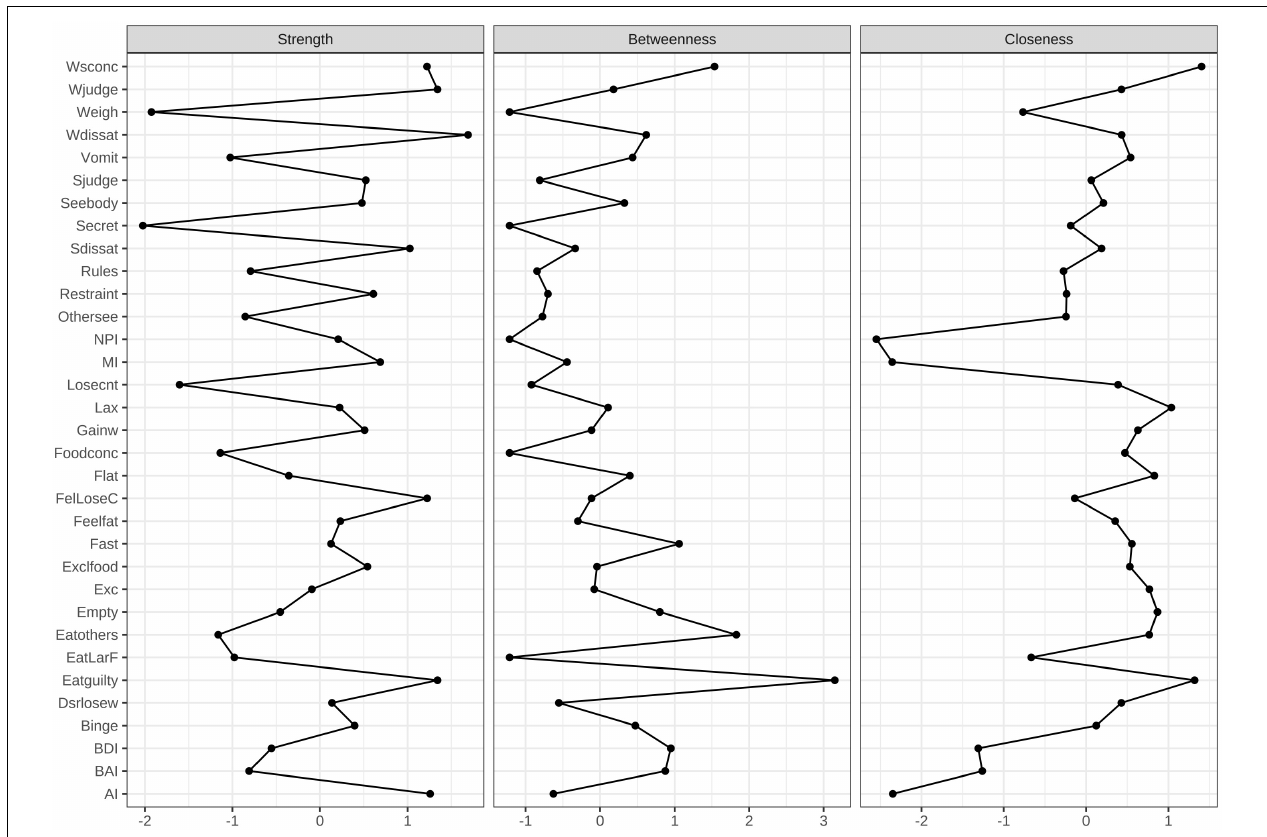
FIGURE 4 | Centrality measures for the HC network representing the strength, closeness, and betweenness of each node. Higher numbers indicate that the item is more central to the network.